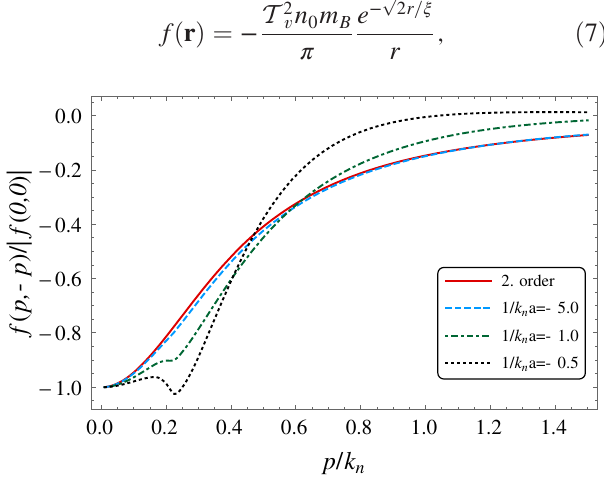
FIG. 2. The Landau effective interaction f ð p ; − p Þ for a zero COM, vanishing impurity concentration, zero temperature, unit ¼ 1 , and k ¼ 0 . 2 . We show the perturbative a mass ratio m=m B n B a ¼ − 5 . 0 (dashed blue curve), result (solid red curve), 1 =k n 1 =k a ¼ − 1 . 0 (dot-dashed green curve), and 1 =k a ¼ − 0 . 5 n n (short-dashed black